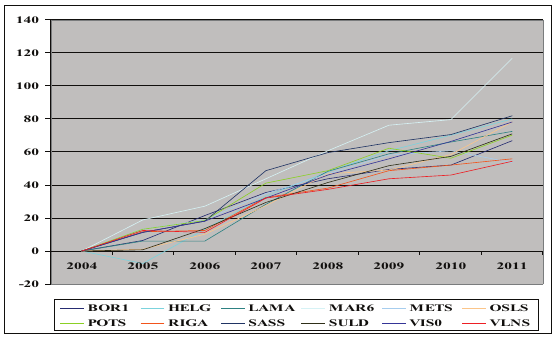
increases annually: the changes in coordinate X of the stations are moving in a negative direction, and the coor- dinates Y and Z are going in a positive direction.